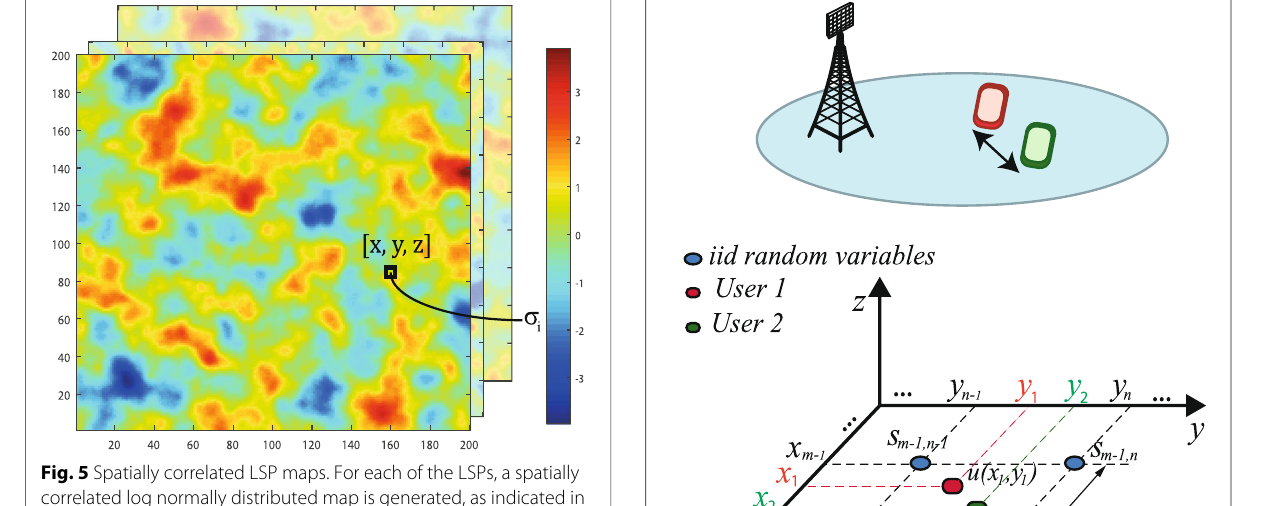
are deleted afterwards. Only the interpolated values are saved for every time slot. This is very important, as for large scenarios saving such grids can have huge